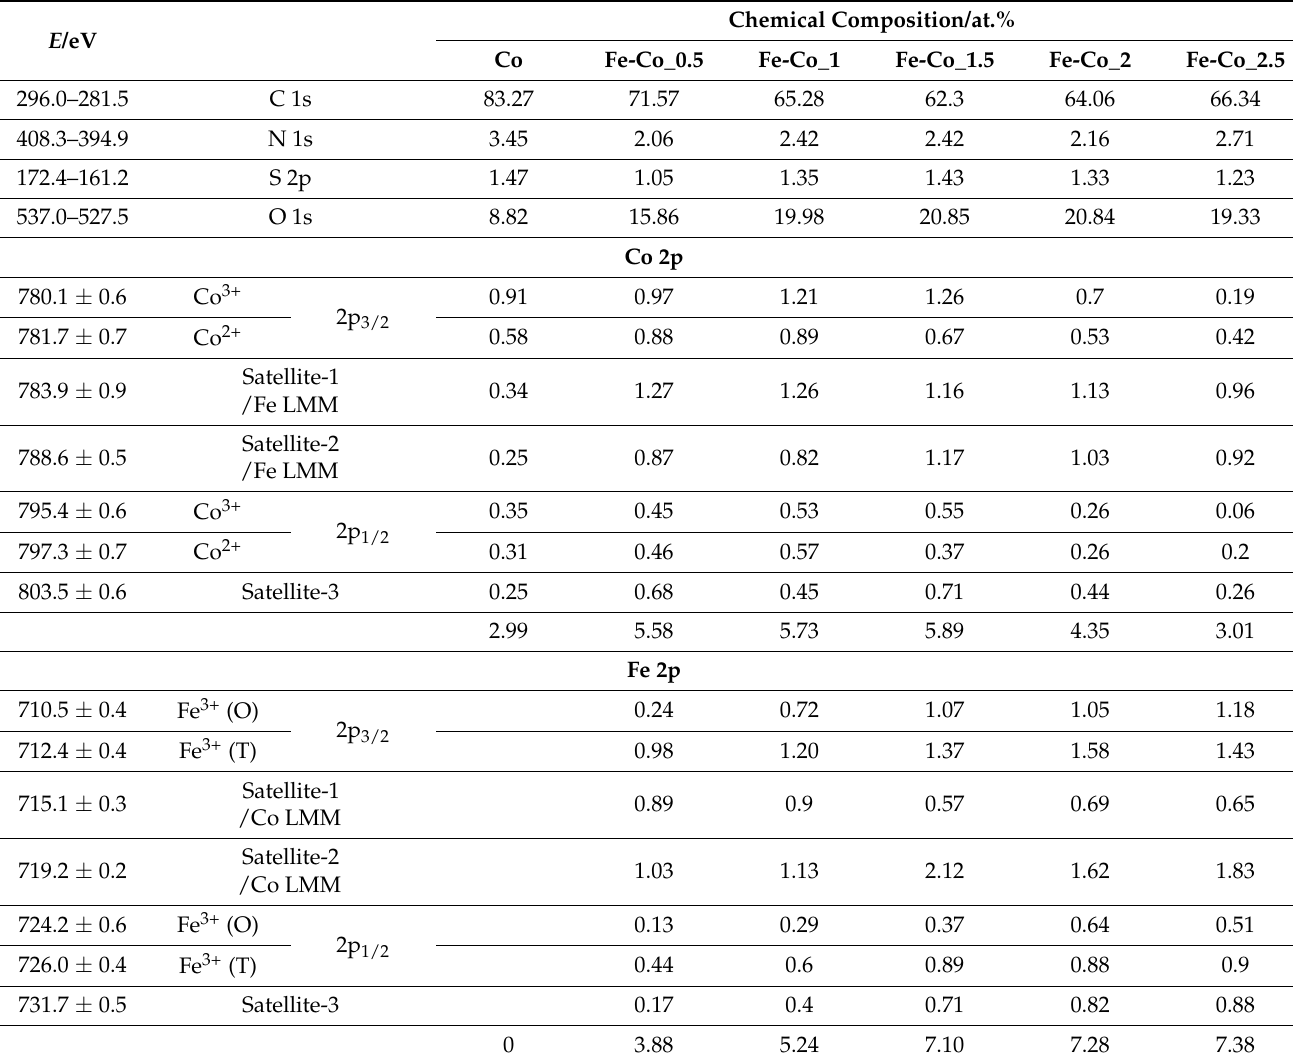
Table 3. Binding energy (E, eV) of the representative XPS emissions for the investigated spinels and calculated chemical